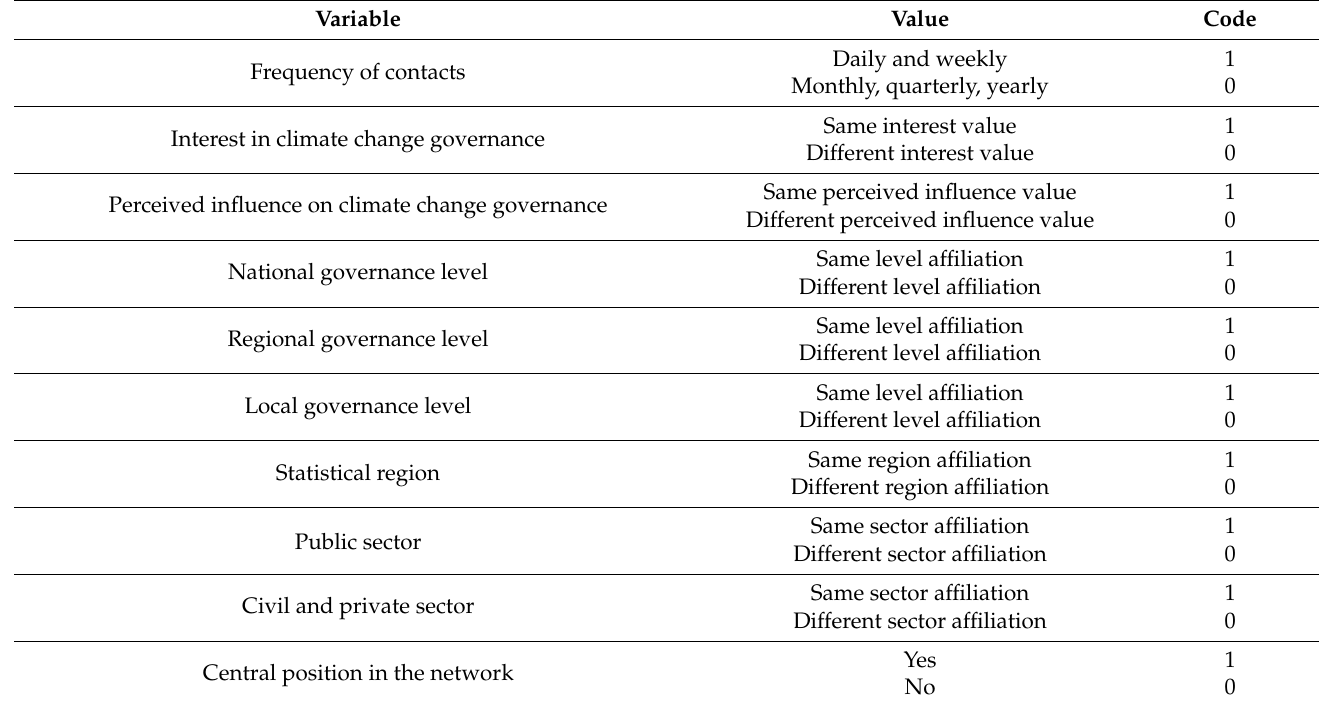
Table 2. Variable coding